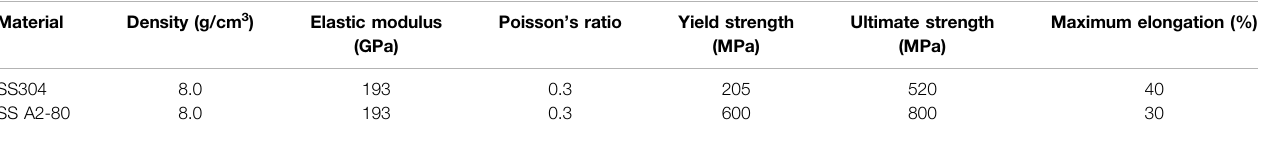
TABLE 1 | Mechanical properties of metallic materials.